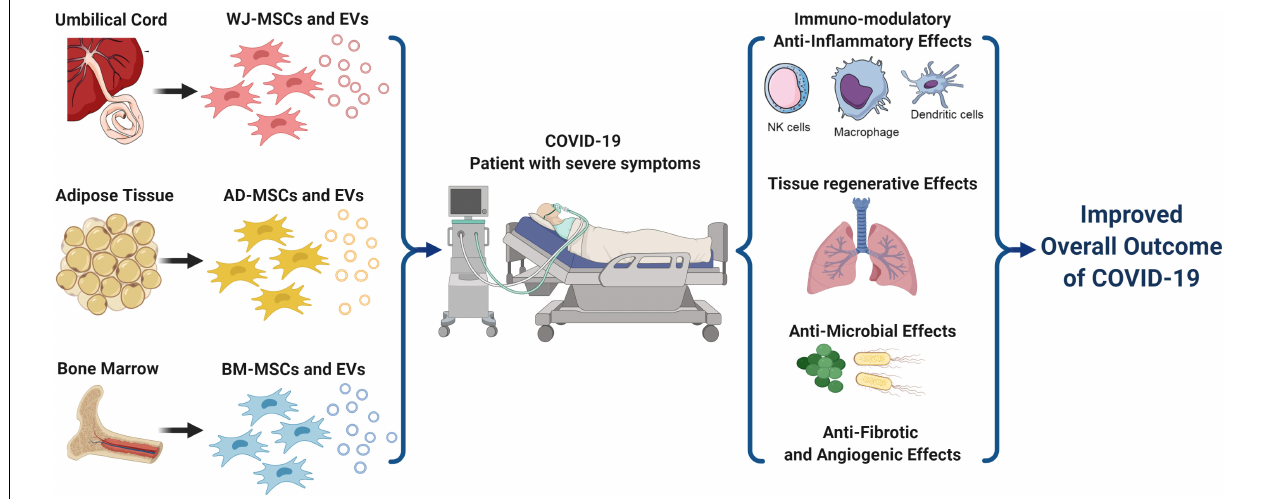
FIGURE 1 | A schematic presentation for the different types of mesenchymal stem cells and their various therapeutic strategies implicated in COVID-19 treatment. MSCs and their derived EVs can efficiently intervene via several mechanisms to improve the overall outcome of COVID-19 especially in critically-ill patients with severe symptoms. These mechanisms include their immunomodulatory activities, tissue regenerative effects, anti-microbial effects, as well as their antifibrotic and angiogenic effects. AD, Adipose tissue; BM, Bone marrow; COVID-19, Corona Virus Disease-2019; EVs, Extra-Cellular vesicles; MSCs, Mesenchymal Stem Cells; and WJ, Wharton’s Jelly. Created by Biorender.com.